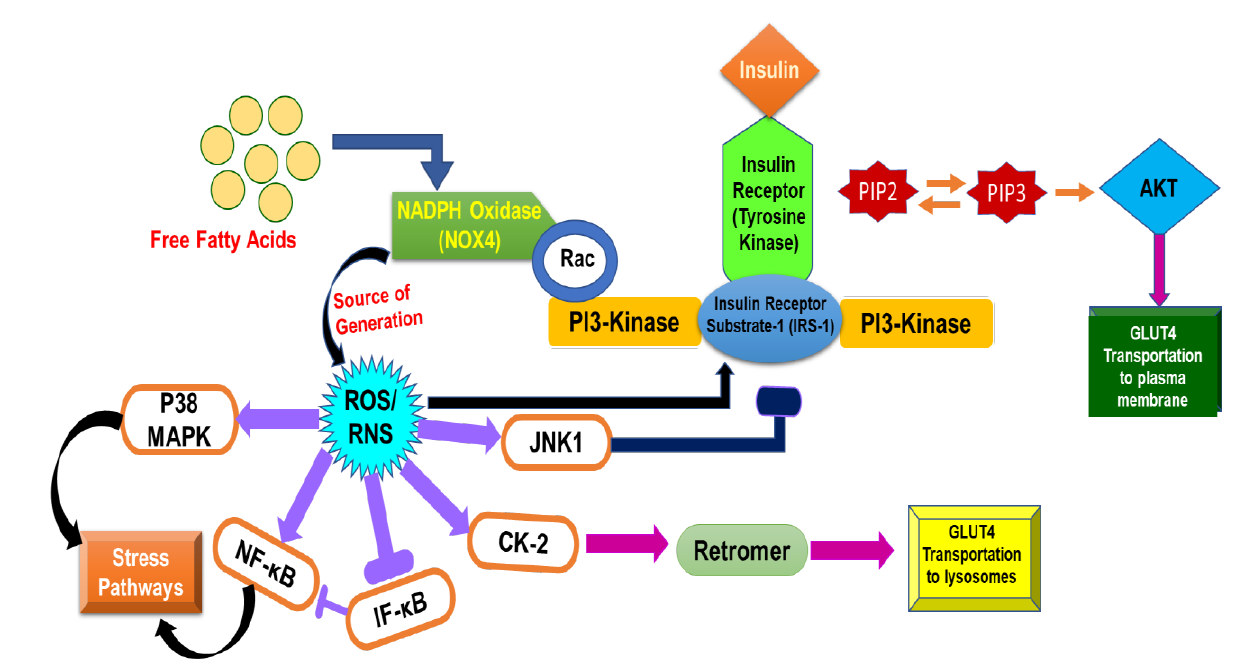
Figure 5. Normal pathway of insulin signaling and inhibitory effect of ROS in insulin signaling.